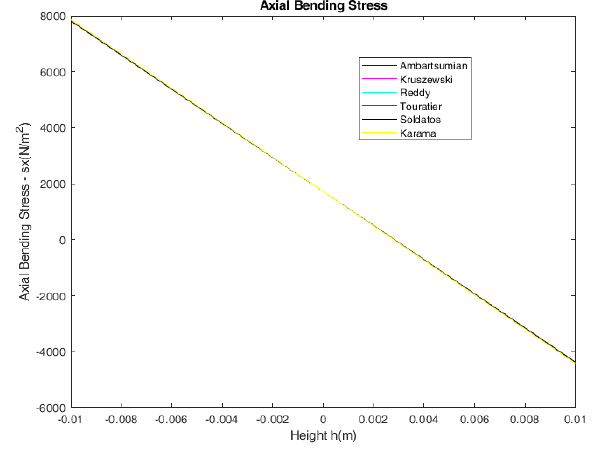
Figure 6. Comparison of axial stress σ x through the height of the beam at ( x = L /2, z ) for all models with aspect ratio S = 30.